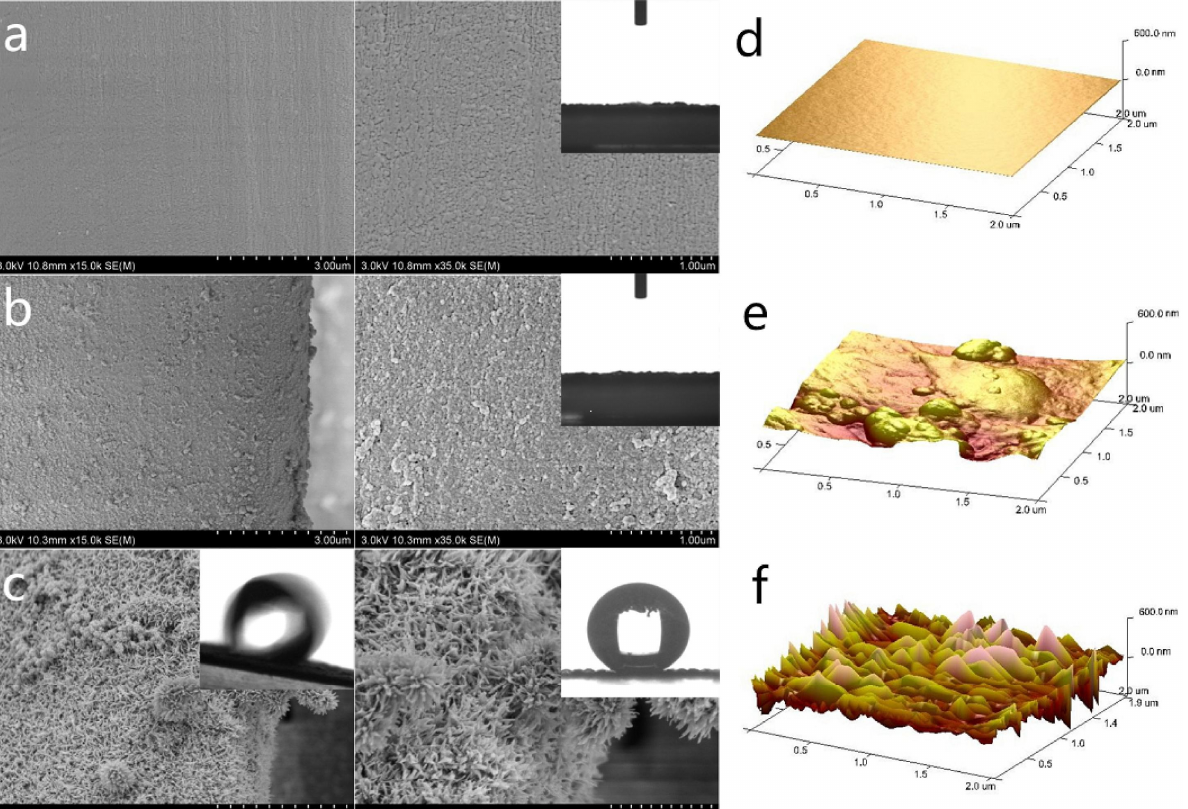
Figure 3. SEM images and AFM images of the silk surface of plain silk fabrics (SF) ( a , d ), a silk surface loaded with polydopamine synthesized by laccase catalytic oxidation of dopamine (PDA-SF) ( b , e ), and needle-like γ -FeOOH crystal grown in situ on a silk surface loaded with polydopamine (PDA-Fe-SF) ( c , f ). The insets in a-c show the corresponding contact angle and sliding angle of the silk fabrics. Reprinted with permission from Ref. [60] Copyright 2020 Elsevier.